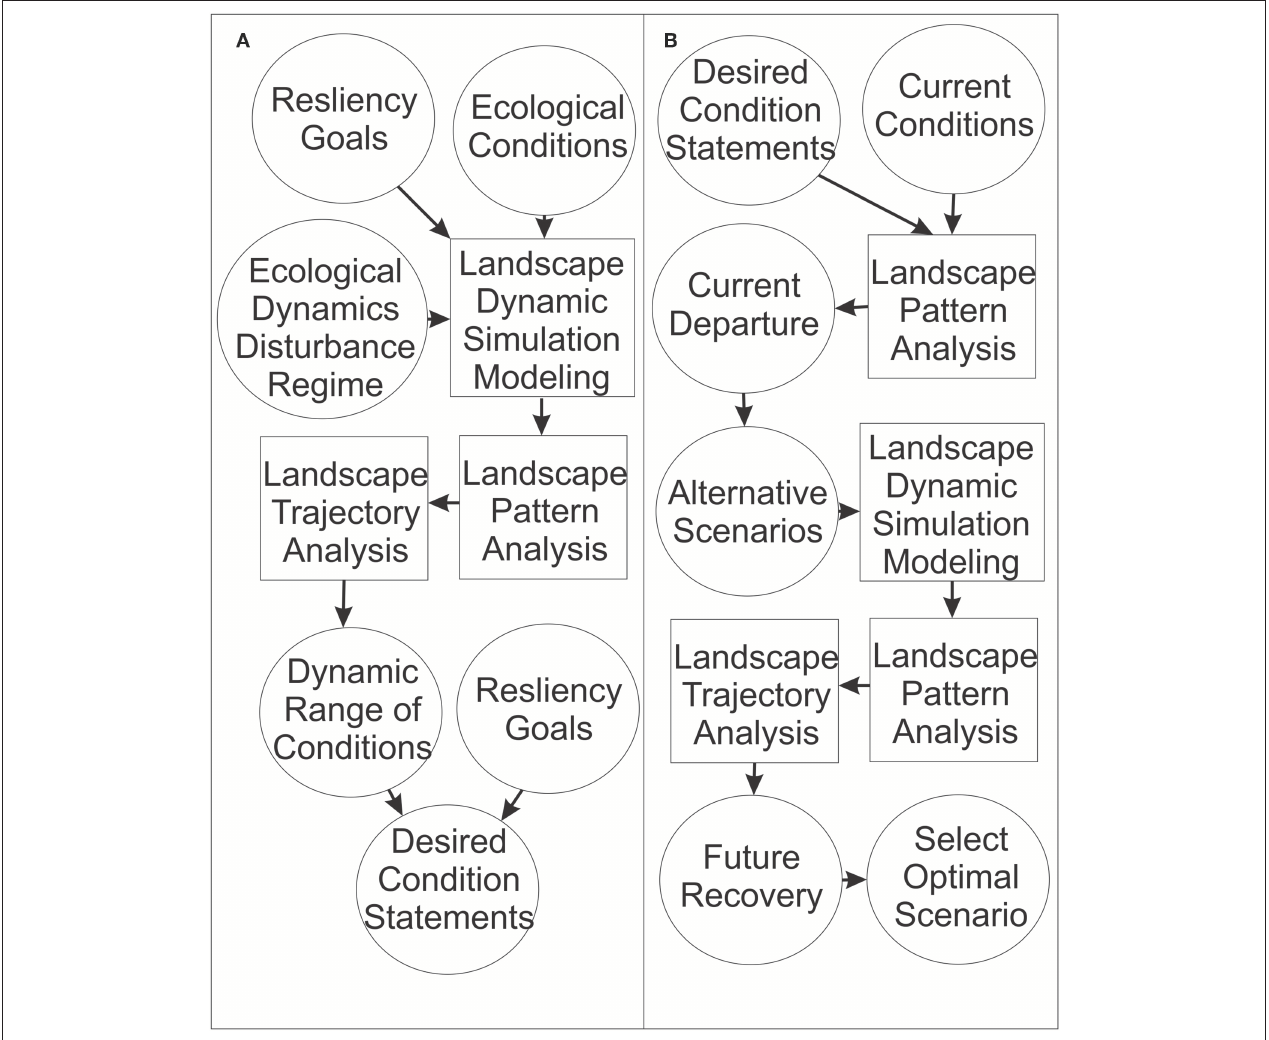
FIGURE 1 | Conceptual diagram of applying landscape pattern analysis, landscape dynamic simulation modeling and landscape trajectory analysis to assess resiliency goals and desired conditions. Circles represent inputs or outputs of the analysis. Boxes represent analytical steps. Arrows represent linkages between inputs, analysis and outputs. (A) Shows the steps in a process of producing quantitative, detailed and specific desired conditions statements from a priori resiliency goals. (B) Shows the process of evaluating alternative scenarios given a priori detailed, specific and quantitative desired condition